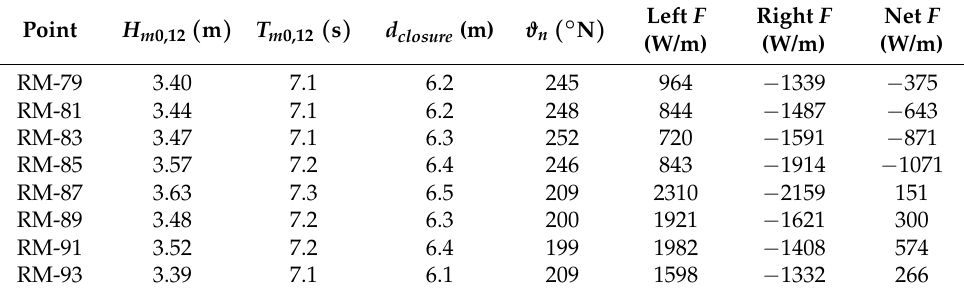
Table 2. Wave parameters at significant positions located at − 10 m (see Figure